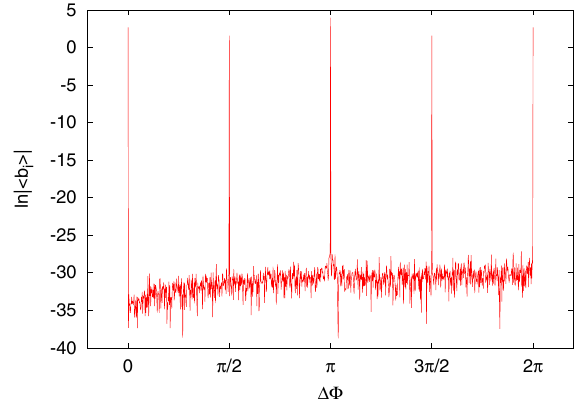
FIG. 10. Averaged cumulated numerical noise h b ~ Z 0 following Eq. (A12). Peaks appear at phase initializations of ij advances Δ Φ ¼ 0 . 0 , Δ Φ ¼ π = 2 , Δ Φ ¼ π , Δ Φ ¼ 3 π = 2 , and Δ Φ ¼ 2 π